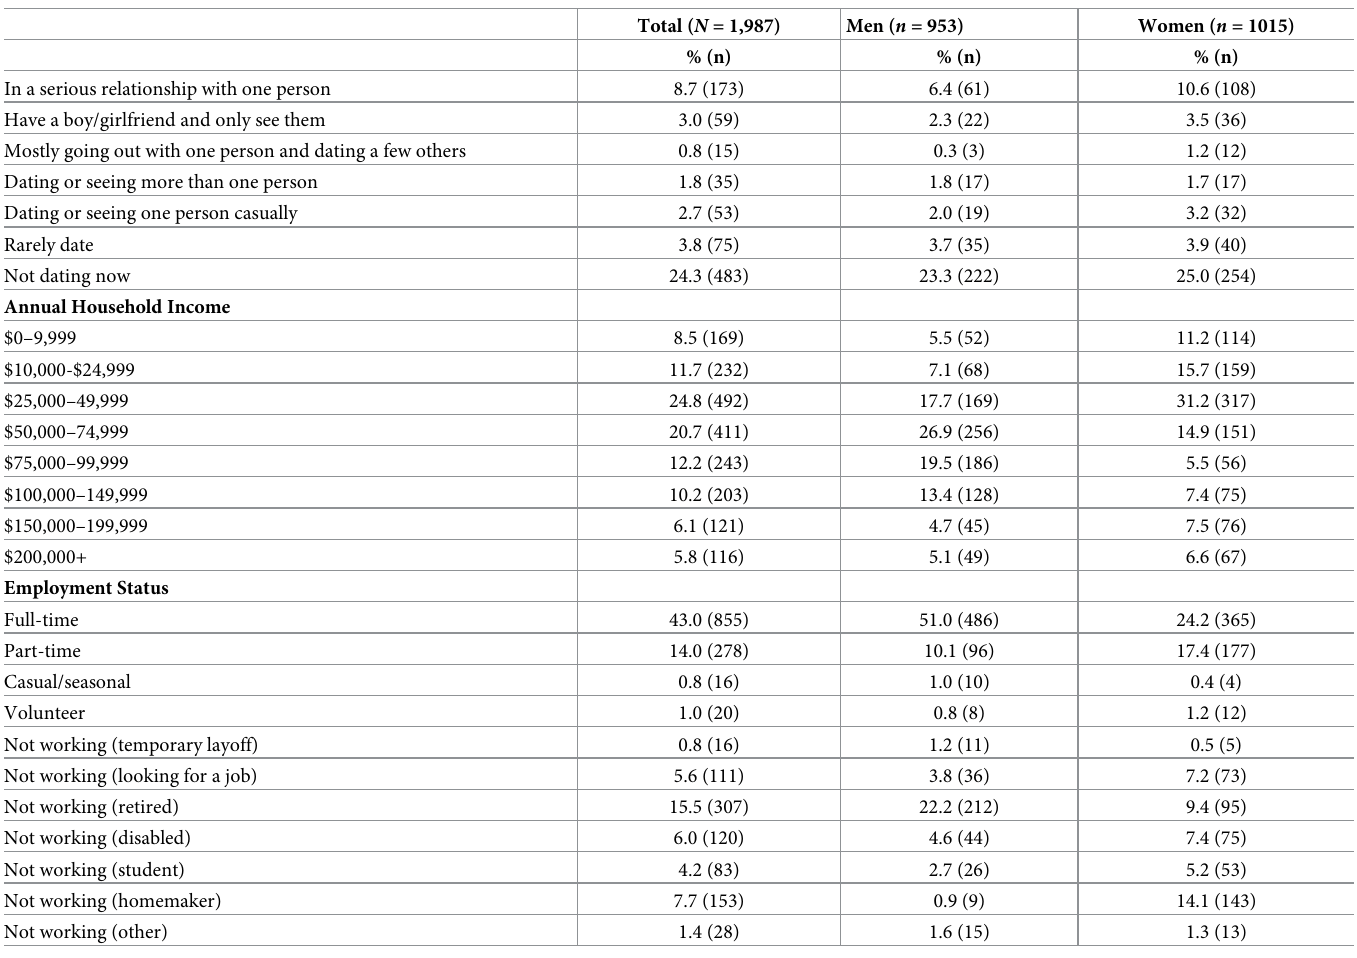
organized based on age bins, the continuous age variables were used in all statistical analyses. Extreme values to free-response questions (~1%) for the number of partners for oral, vaginal, and anal sex for lifetime and the past 12 months were winsorized. One-way ANOVAs were then used to test for mean differences in the frequency of sexual behaviors (past 12 months and 30 days), the number of sexual partners (lifetime and past 12 months), and age at sexual initiation across relationship status, sexual orientation, race, and ethnicity. Post hoc comparisons using the Tukey HSD test ( α = .005) were used to test for sig- nificant differences among respondents either in a serious relationship, casually dating, or not currently dating or in a relationship (relationship status); reporting a 100% heterosexual, mostly heterosexual, bisexual, mostly homosexual, and 100% homosexual orientation (sexual orientation); and identifying as either White, African American or Black, Asian or Asian American, and multiracial (race). Differences between Hispanic and non-Hispanic respon- dents were examined using t- test procedures. All analyses were conducted using SPSS version